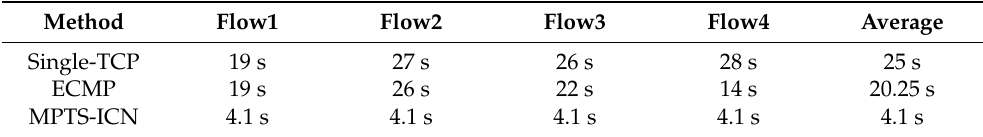
Table 2. Flow completion time under different